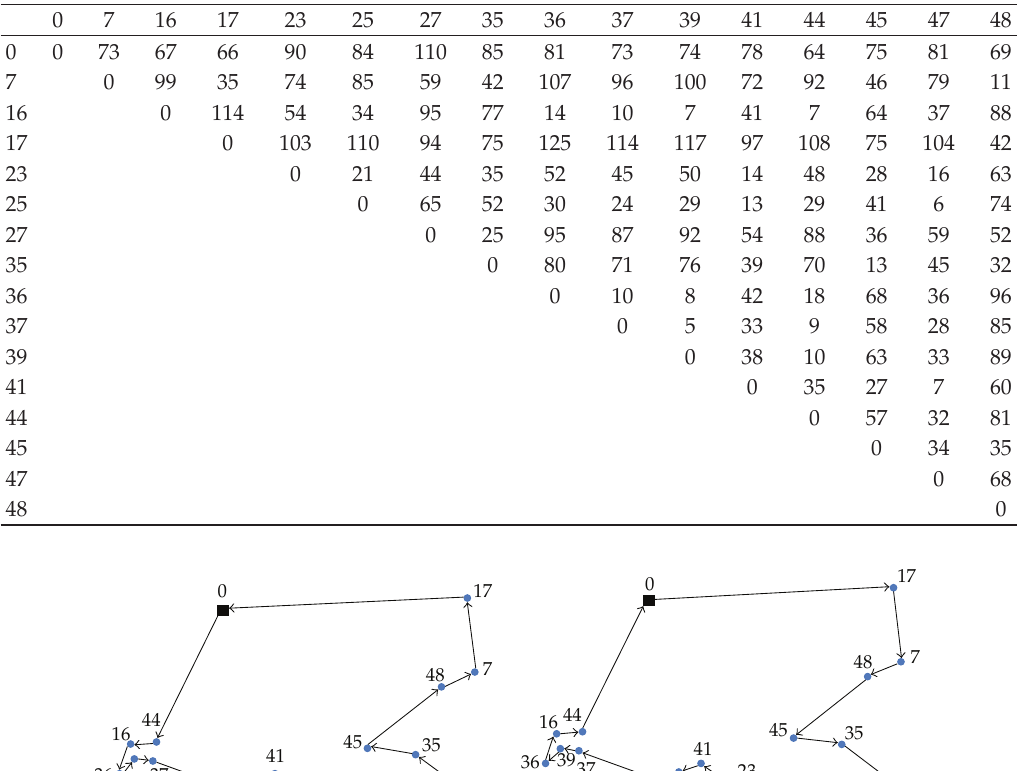
Table 1: The symmetric travel time matrix of example in Figure 1 (cid:6) b (cid:7) .